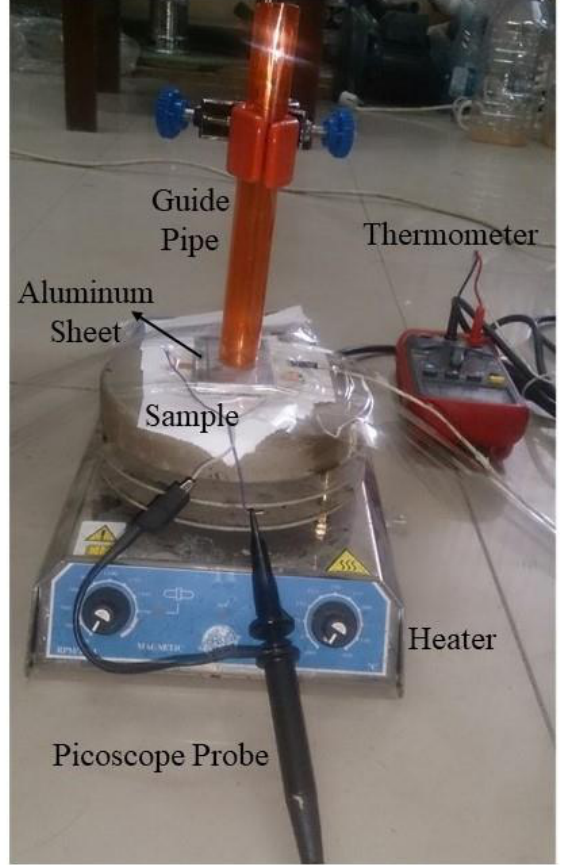
Figure 2. Experimental setup of the impact test during temperature variations.